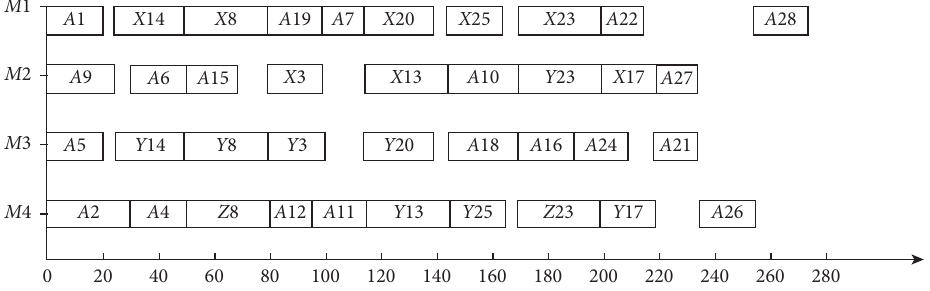
Figure 9: Scheduling results of the reverse multidevice first adaptation algorithm.